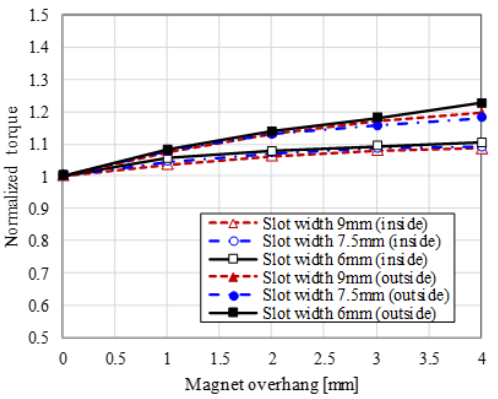
Figure 15. Generated torque with respect to magnet overhang.